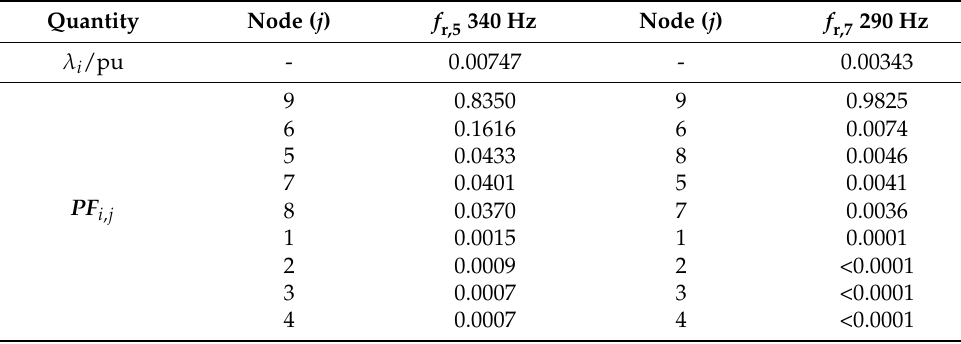
Table 2. Eigenvectors and participation factors of the industrial system.